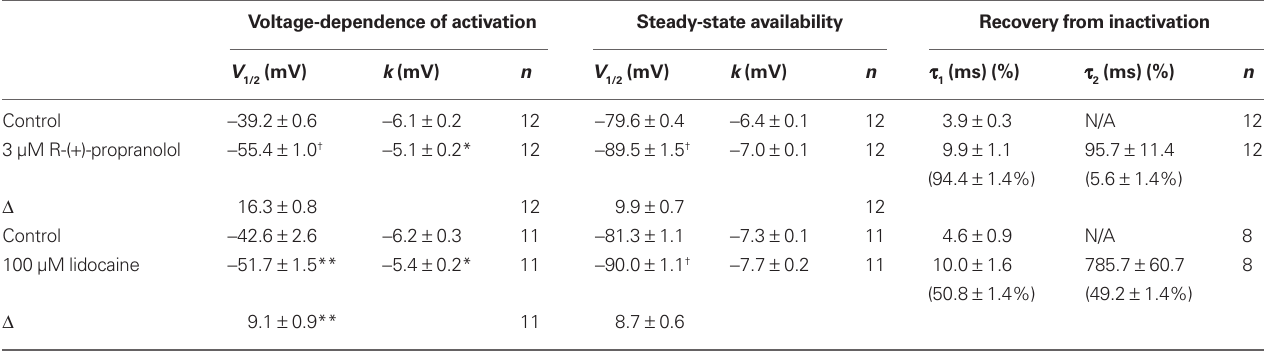
Table 1 | effects of r-( + )-propranolol and lidocaine on Na 1.5 biophysical properties. V Voltage-dependence of activation Steady-state availability recovery from